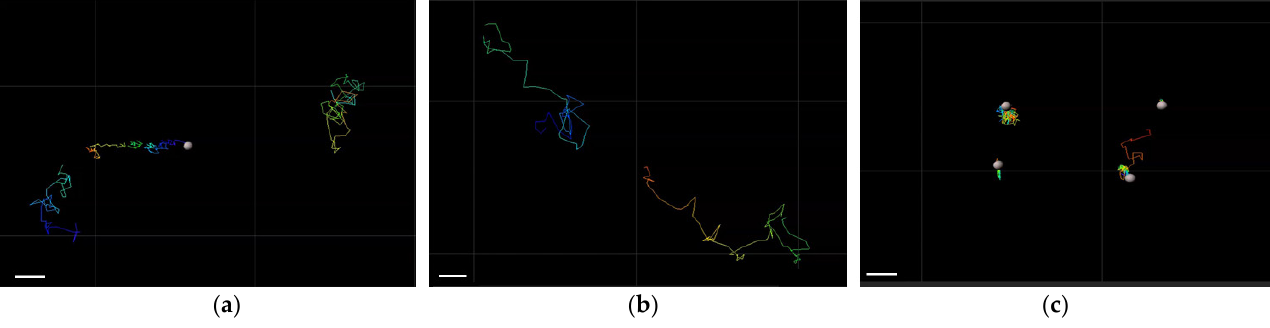
Figure 2. Trajectories of different nanoparticles based in the intact porcine vitreous: anionic P[EF]-2 nanoparticles ( a ), anionic P[KF] D,L -2/HEP nanoparticles ( b ) , and cationic P[KF] D,L -2 nanoparticles ( c ). Nanoparticles based on P[EF]-2 were labeled with Cy5; P[KF] D,L -2-based samples were labeled with Cy3 dye. Scale bar corresponds to 2 μ m.